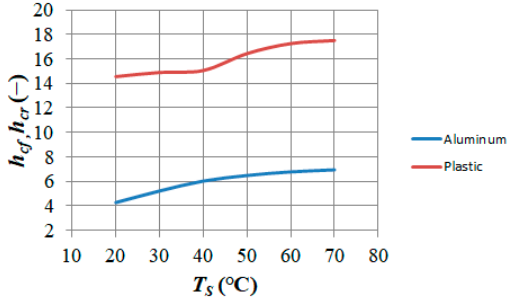
Figure 6. The variation range of h cf , h cr coefficients.